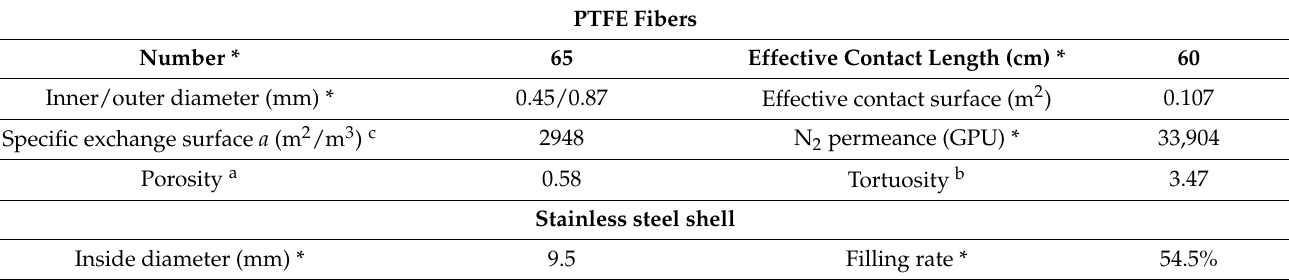
Table 4. Technical specifications of the membrane